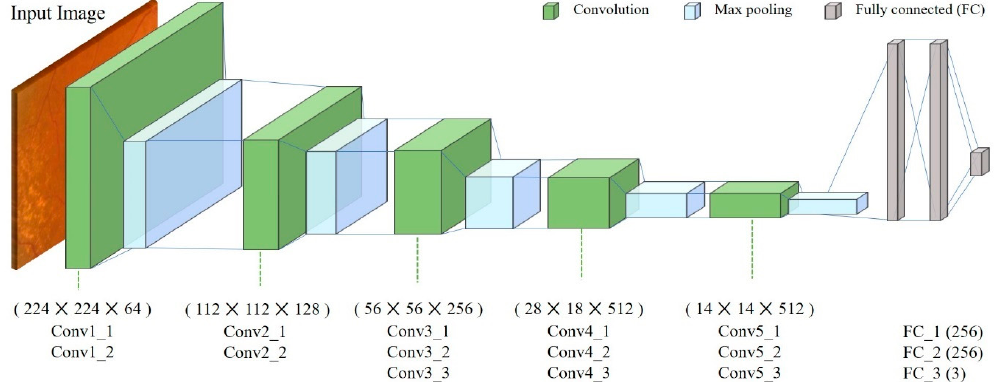
Figure 1. The proposed convolutional neural network (CNN) architecture (a modified Visual Geometry Group with 16 layers (VGG16) model). The CNN with the modified VGG16 model used 3 × 3 convolutional layers and 2 × 2 pooling layers. Convolutional layers and fully connected layers were trained with macular